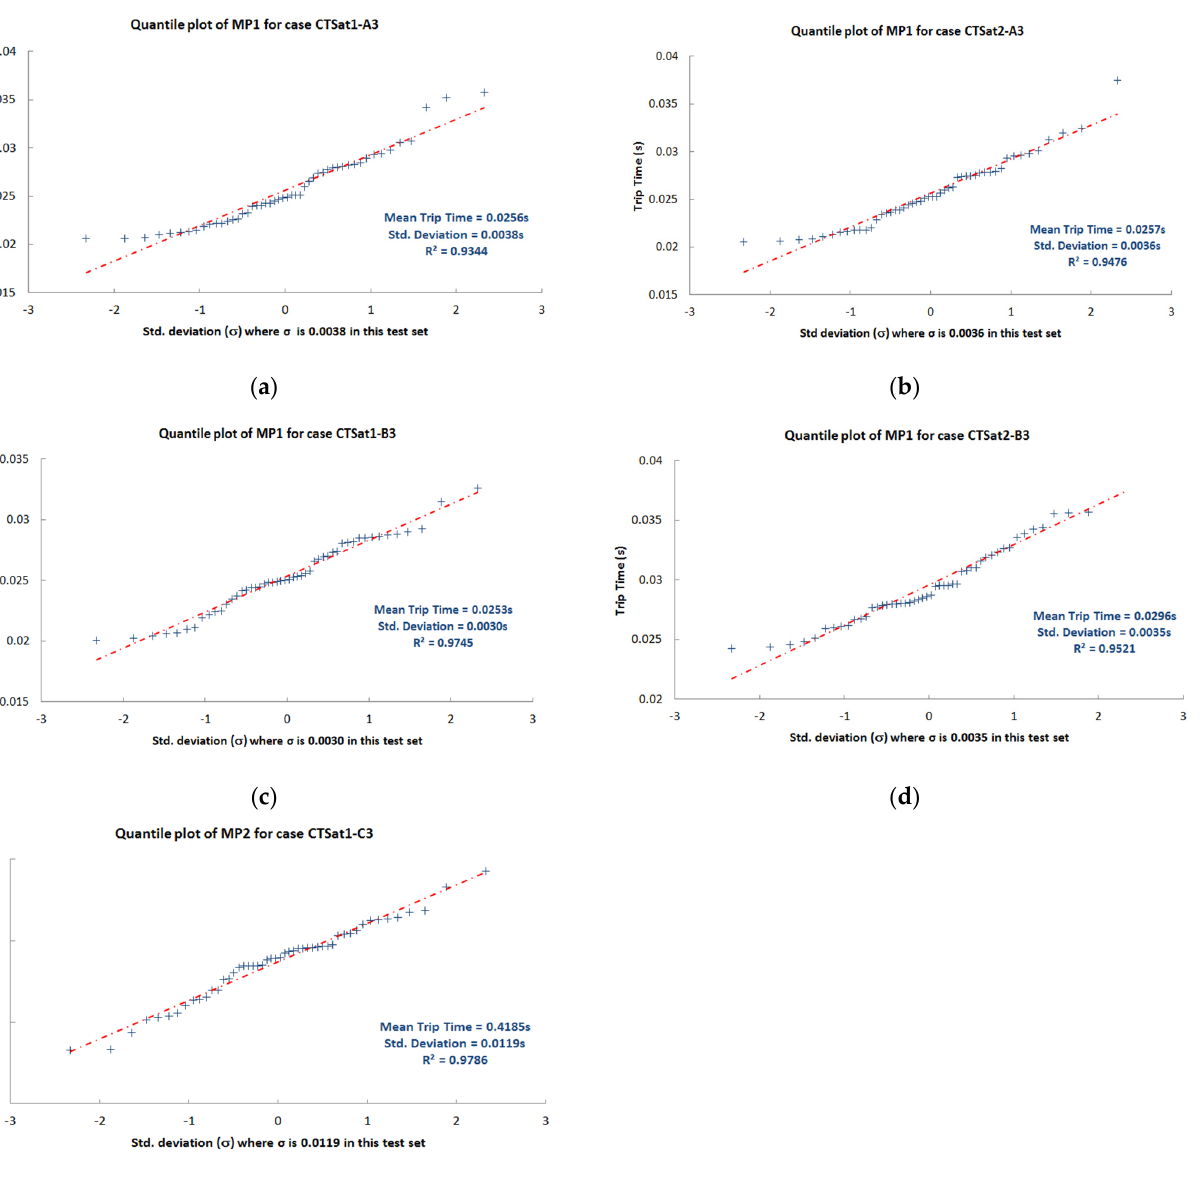
( b ) Figure 21. Comparisons: ( a ) CTSat1-A3, CTSat1-B3 and CTSat1-C3 (light CT saturation, no/one faulty component, L-L-G fault at 100% of the feeder); ( b ) CTSat2-A3 and CTSat2-B3 (deep CT satu- ration, no/one faulty component, L-L-G fault at 100% of the feeder). Comparisons of CTSat2-A3, CTSat2-B3 Since the impact of a faulty AMU + deep CT saturation on both MP1 and MP2 for case CTSat2-C3 is significant as both MP1 and MP2 do not operate correctly, no results were obtained for case CTSat2-C3. Hence, only CTSat2-A3 and CTSat2-B3 are considered and compared. When considering deep CT saturation (Sat2), the MP1 trip times of CTSat2- A3 and CTSat2-B3 are sorted from the fastest to the slowest in ascending order, as shown in Figure 21b. The trip time in both case CTSat2-A3 and CTSat2-B3 are similar, as in both